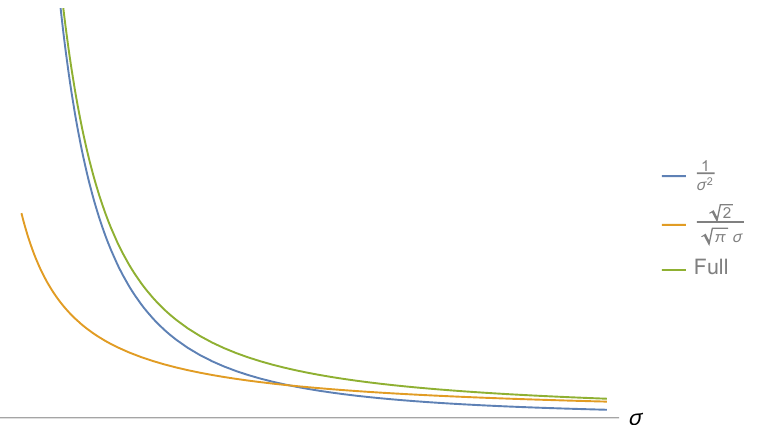
Figure 2: Qualitative plot of the right hand side of eq.(64) and asymptotic behavior for large and small σ